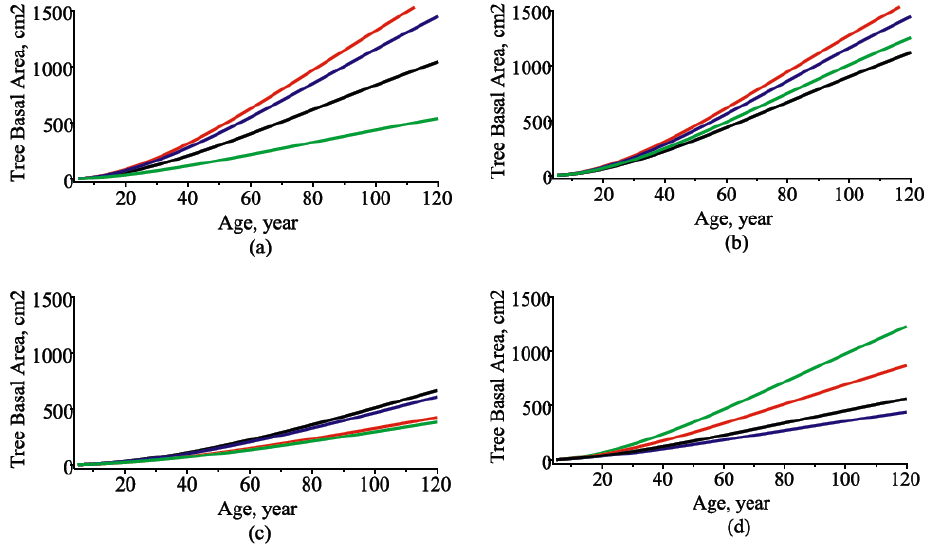
Figure 5. Kinetics of the mean tree basal area for four randomly selected stands from a validation dataset: ( a ) all species; ( b ) pine ( Pinus sylvestris ); ( c ) spruce ( Picea abies) ; ( d ) silver birch ( Betula pendula Roth and Betula pubescens Ehrh.); black — first stand; red — second stand; blue — third stand; and green — fourth stand.